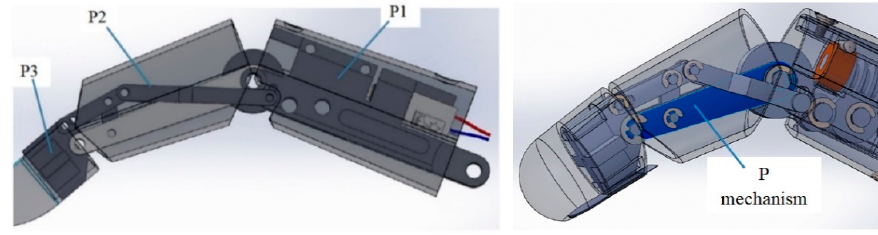
Figure 9. Simulation of fingertip trajectories.